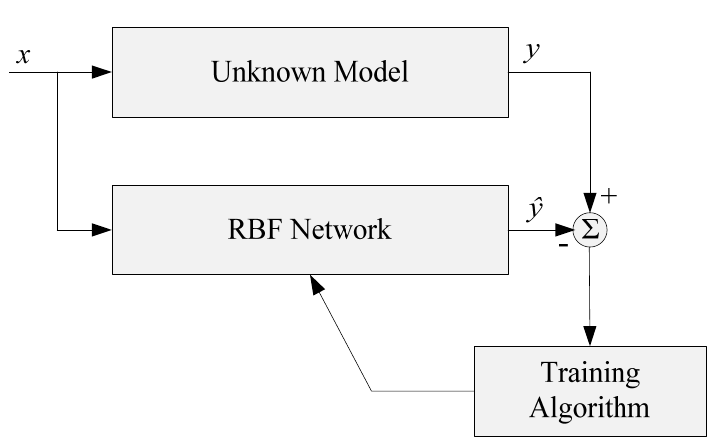
Figure 1. Block diagram of a RBF